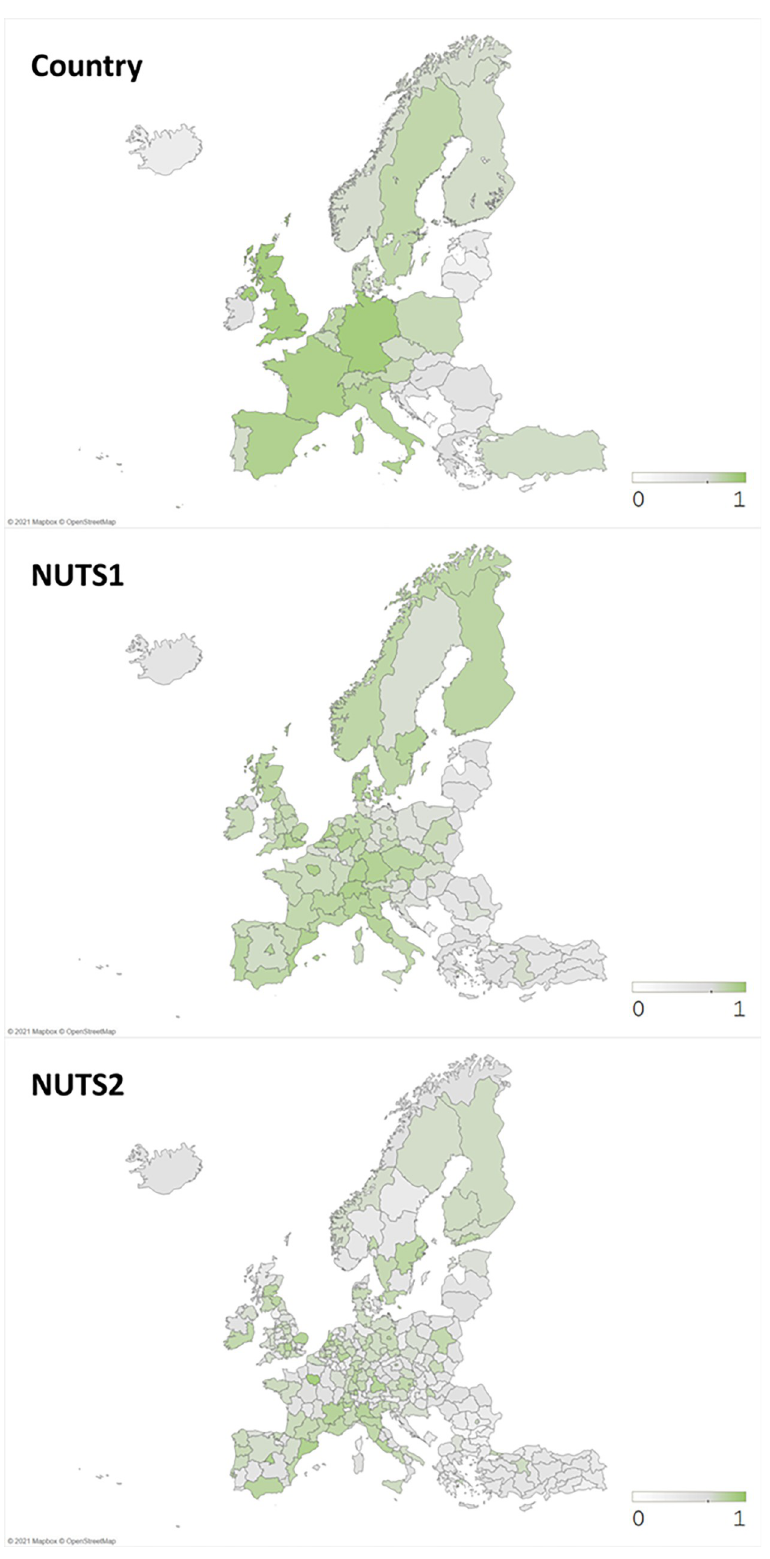
Fig 3. Number of funded publications (in normalized log scale). Source: Authors’ illustration.